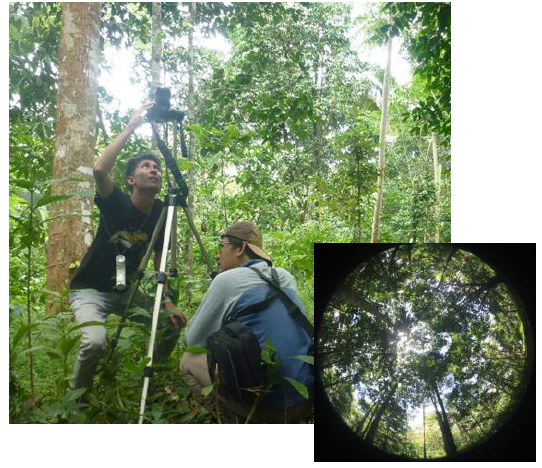
Figure 2. Hemispherical view acquisition and its